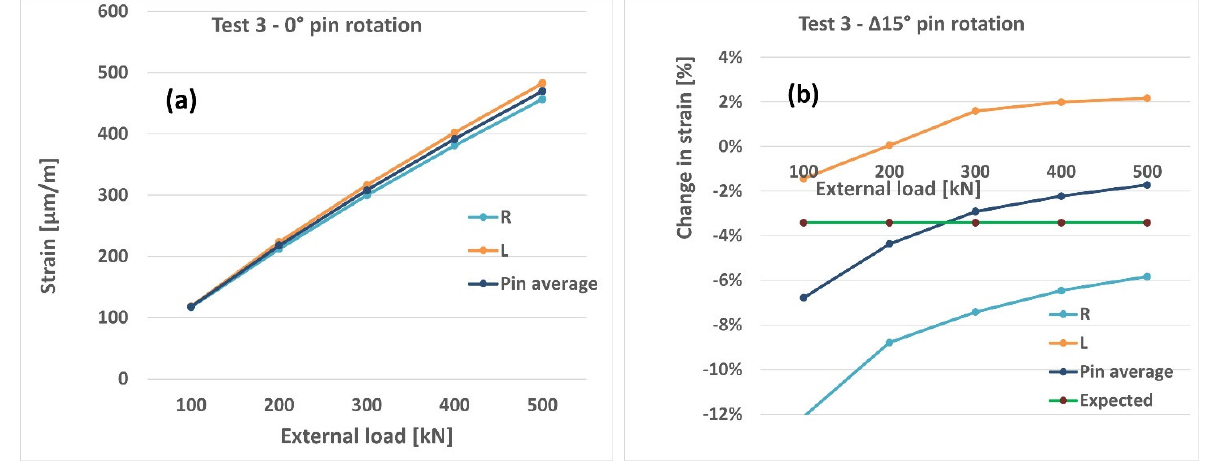
Figure 10. Test 2, ( a ) strains at 0° position, ( b ) percentage change of strains from 0° to 15° position.